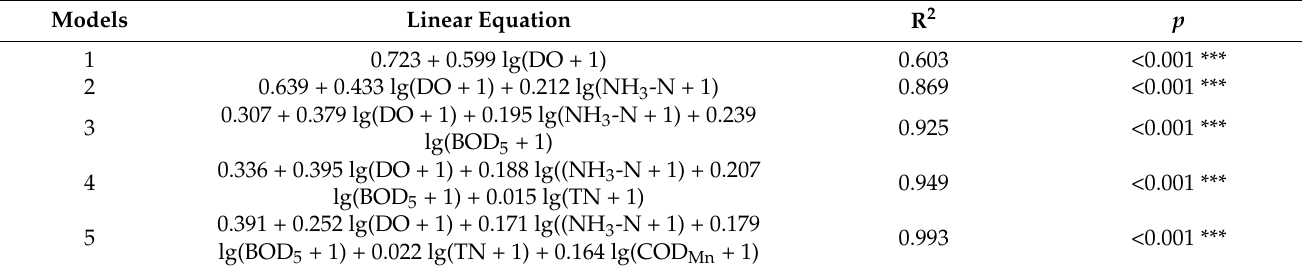
Table 4. Parameter selection results via stepwise multiple linear regression for the WQImin model based on the training dataset (n =